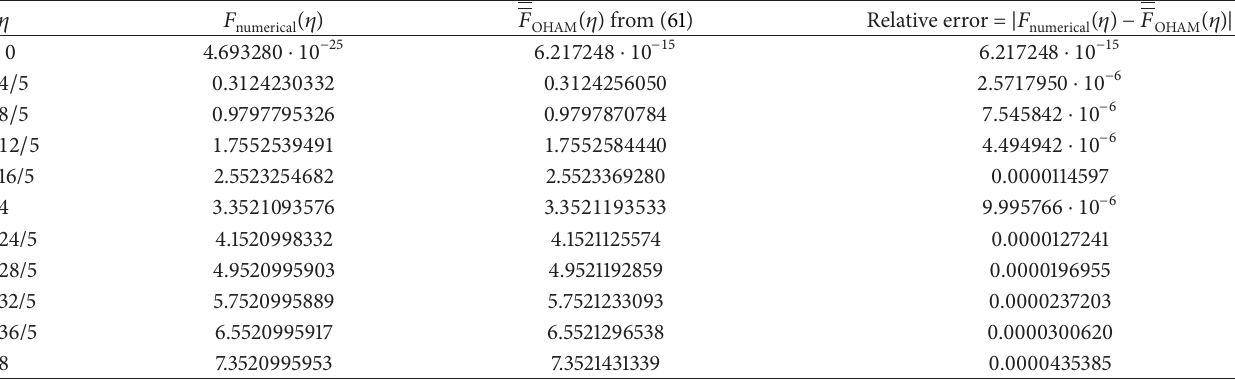
Table 14: Comparison between OHAM results given by (61) and numerical solutions for 𝛽 = 1 . 𝜂